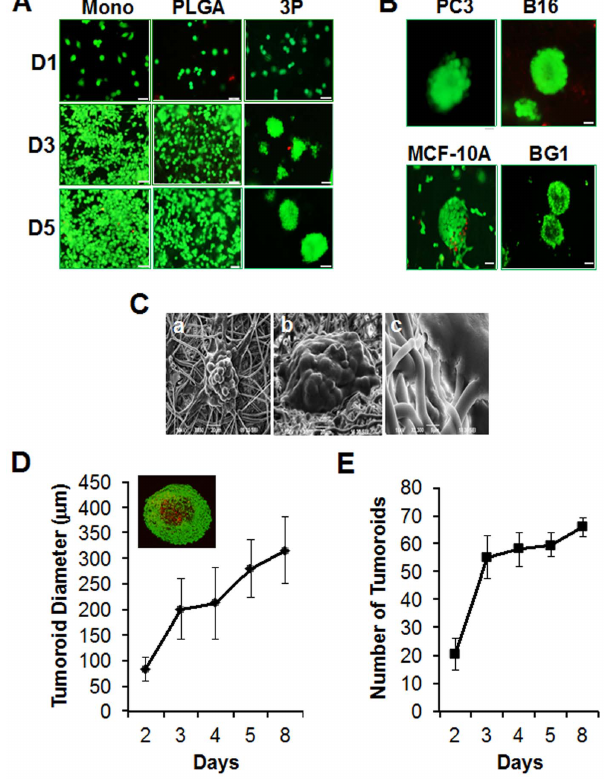
Figure 2. Growth of tumoroids on scaffolds. (A) LLC1 cells (5 6 10 3 ) were cultured on monolayer, PLGA and 3P scaffolds from day 1 to day 5. Scale bar=50 m m. (B) Growth of PC3, B16, MCF-10A and BG1 cancer cells as tumoroids on 3P scaffold. Scale bar=20 m m. (C) SEM of LLC1 tumoroid (a) at day 3 and MCF7 tumoroid (b–c) at day7. (D) The average size of LLC1 tumoroids on 3P scaffold from day 2 to day 8. Four scaffolds/time point and 5 tumoroids/ scaffold examined. The inset shows a confocal image of a representative day 20 tumoroid. (E) Average number of tumoroids per scaffold (n=32). Cells were stained with calcein AM/EthD-1 to detect live (green) and dead (red)